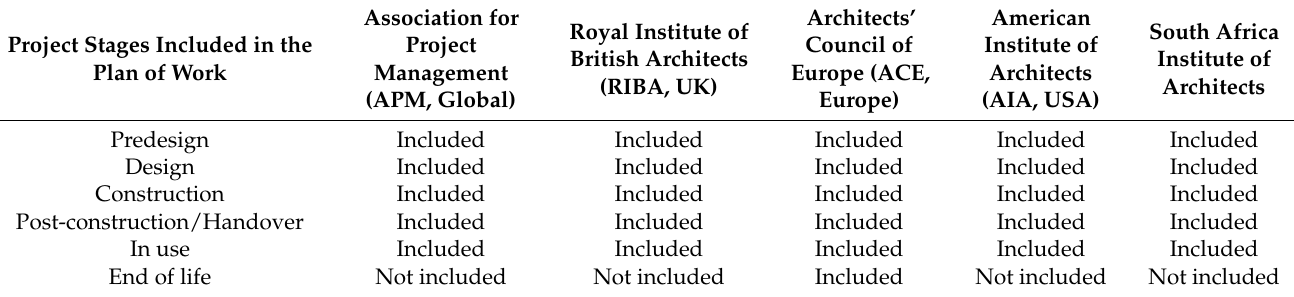
Table 1. Overview of end of life (EoL) in existing plans of work. Source: RIBA plan of work [40].